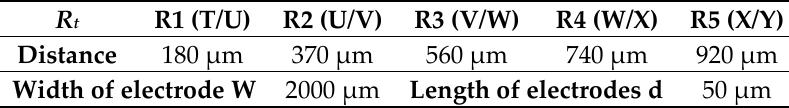
Figure 1. ( a ) Electrode structure with active sensor area (green); and ( b ) reverse side of the chip with heater and temperature sensor structure; ( c ) Dependency of R1 to R5 on electrode spacing l according to Equation (1). Table 1. Electrode distances for TLM measurements (Figure 1).